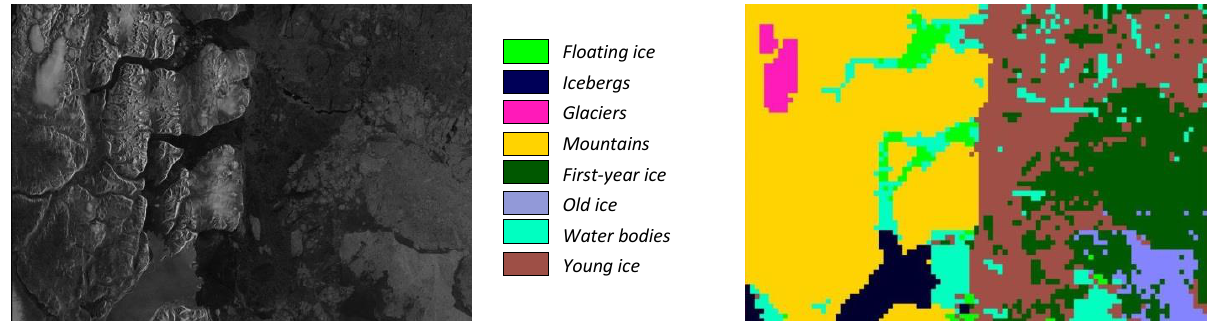
Figure 4 (left). Network structure of the encoder. “None” refers to the batch size being used for training which, in this case, was 32. (right) Network structure of the decoder.